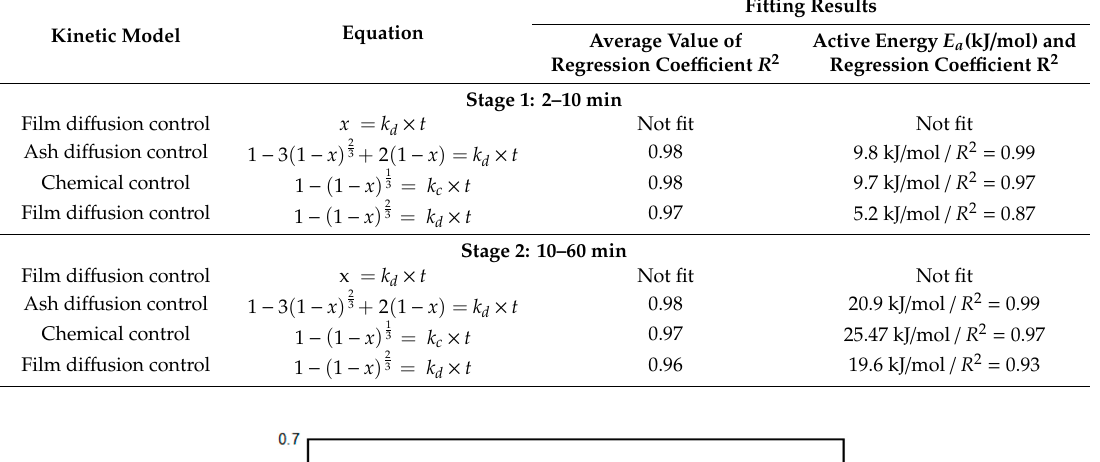
Figure 7. Plot of [ 1 − 3 ( 1 − x ) 3 + 2 ( 1 − x )] versus leaching time at di ff erent temperature. Table 2. Fitting leaching data to kinetic model equations in two leaching stages.